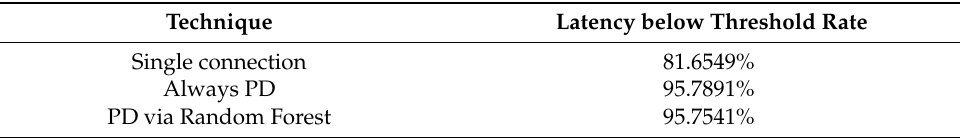
Table 3. Latency below the threshold rate for the different